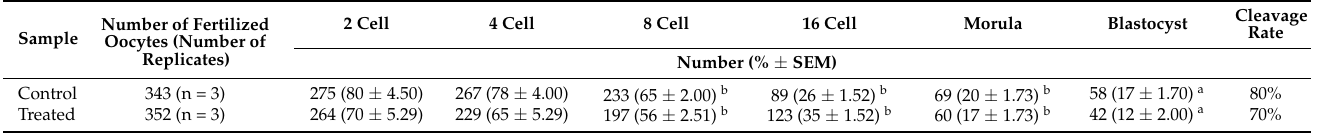
Figure 6. Effect of ghrelin addition on early embryonic development in sheep. ( A ) Diagram of fertilization and early embryonic development in vitro. ( B ) Cell morphology during fertilization and early embryonic development in vitro. I. Fertilization, II. Fertilization finish, III. 2 cell, IV. 4 cell, V. 8 cell, VI. 16 cell, VII. Morula, VIII. Blastocyst. Scale bar: 20 μ m. Table 6. Number of early cleavage of embryos.